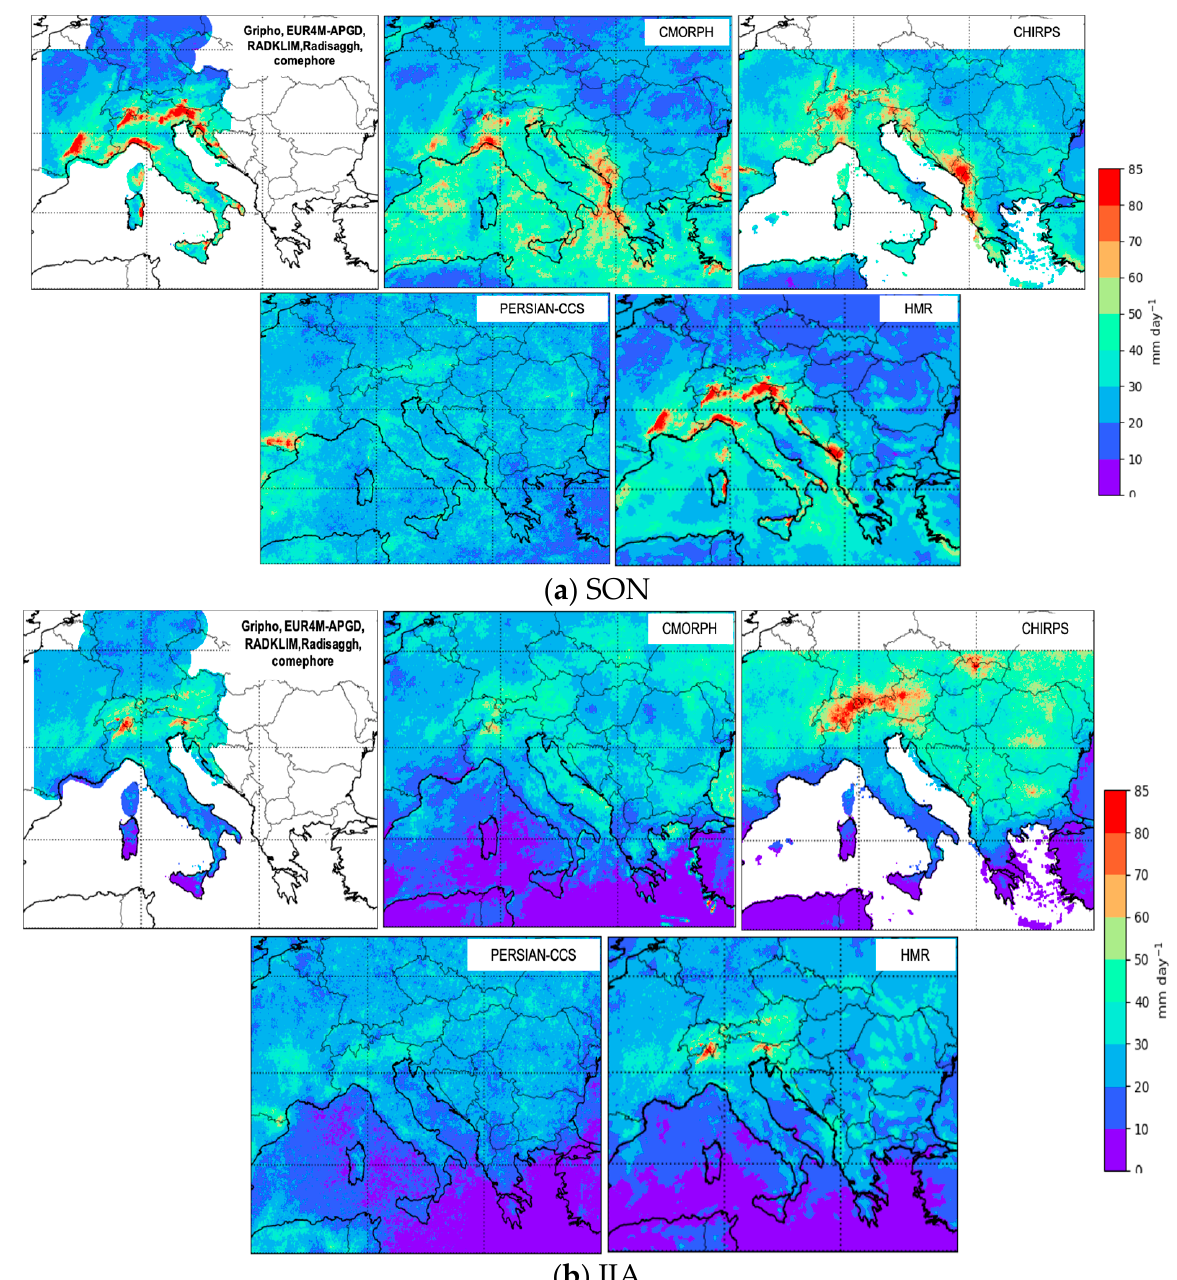
Figure 5. Similar to Figure 3 but for p99.